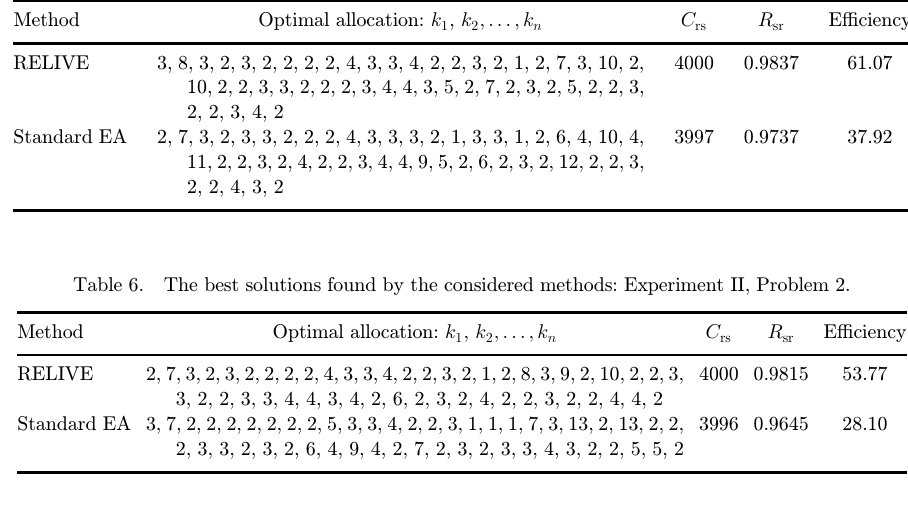
Table 5. The best solutions found by the considered methods: Experiment II, Problem 1. Method